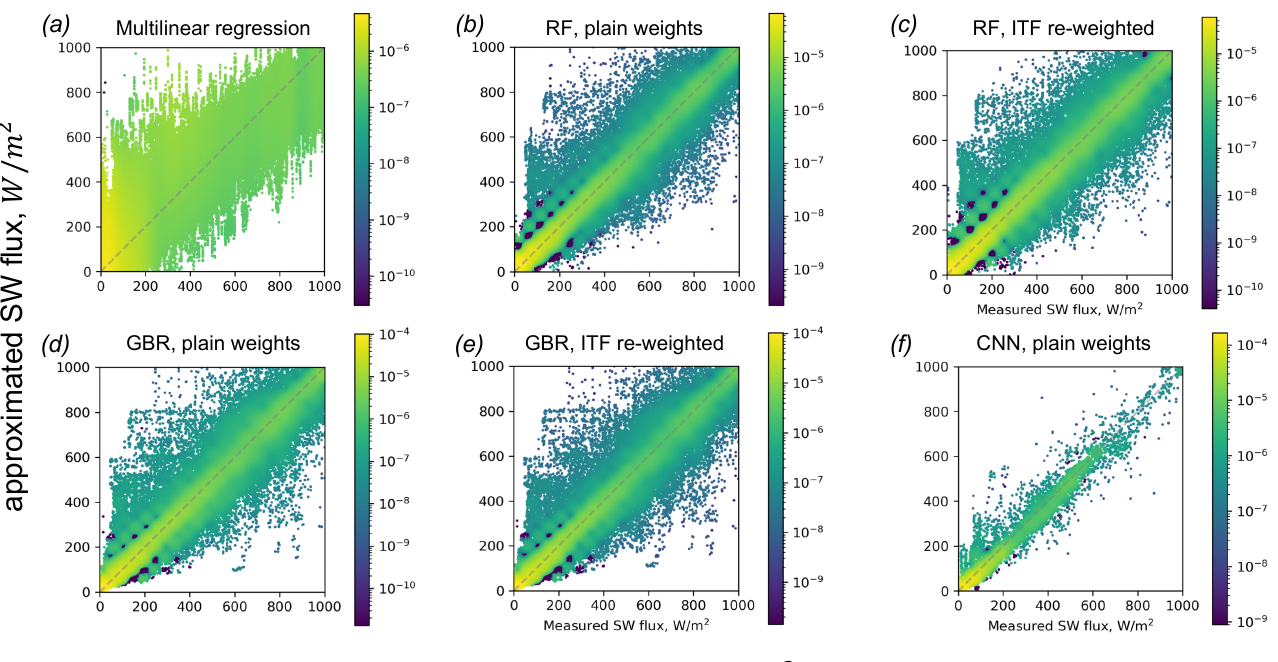
Figure 6. Value mapping diagrams for: ( a ) Multilinear Regression as a baseline; ( b ) Random Forests without ITF re-weighting; ( c ) Random Forests using ITF re-weighting of train subset; ( d ) Gradient Boosting for Regression without ITF re-weighting; ( e ) Gradient Boosting for Regression using ITF re-weighting of train subset; ( f ) convolutional neural network (no re-weighting). Here, density colormaps are logarithmic for presentation purposes. Each diagram has been provided with a diagonal dashed line representing an ideal model approximating SW flux without any